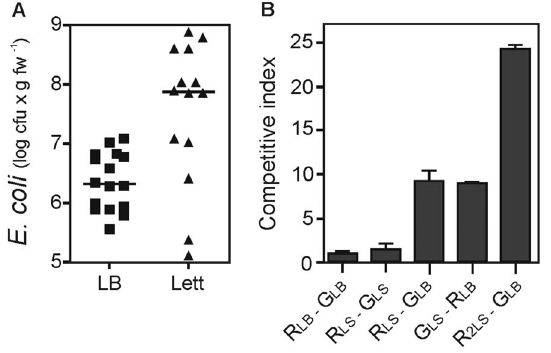
Figure 4. Escherichiacoli adaptation to lettuce seedlings. (A) Data from individual assays of the colonization of lettuce leaves with non- adapted E. coli K12 strain MG1655 cultivated in LB medium (LB) or plant-adapted E. coli strain MG1655 freshly isolated from colonized lettuce leaves (Lett). The bars represent the median value of the data sets. (B) Competitive index (CI) analysis of the adaptation of E. coli K12 to colonize lettuce seedling. R LB and G LB are non-adapted (cultivated in LB medium) RFP- or GFP-labeled bacteria, respectively. R LS and G LS are RFP- or GFP-labeled, plant-adapted bacteria (isolated from colonized lettuce leaves). R 2LS are RFP-labeled bacteria adapted by two consecutive cycles of colonization of lettuce seedlings (isolated from leaves colonized with R LS bacteria). Each data point in (A) (16 for non- adapted bacteria and 14 for adapted bacteria) corresponded to independent assays conducted at 4 to 6 different times over the course of two years. In (B) three assays per condition were conducted at two different times. Each assay (data point) consisted of three seedlings that were inoculated with bacteria in the same test tube. Differences were statistically significant (P #